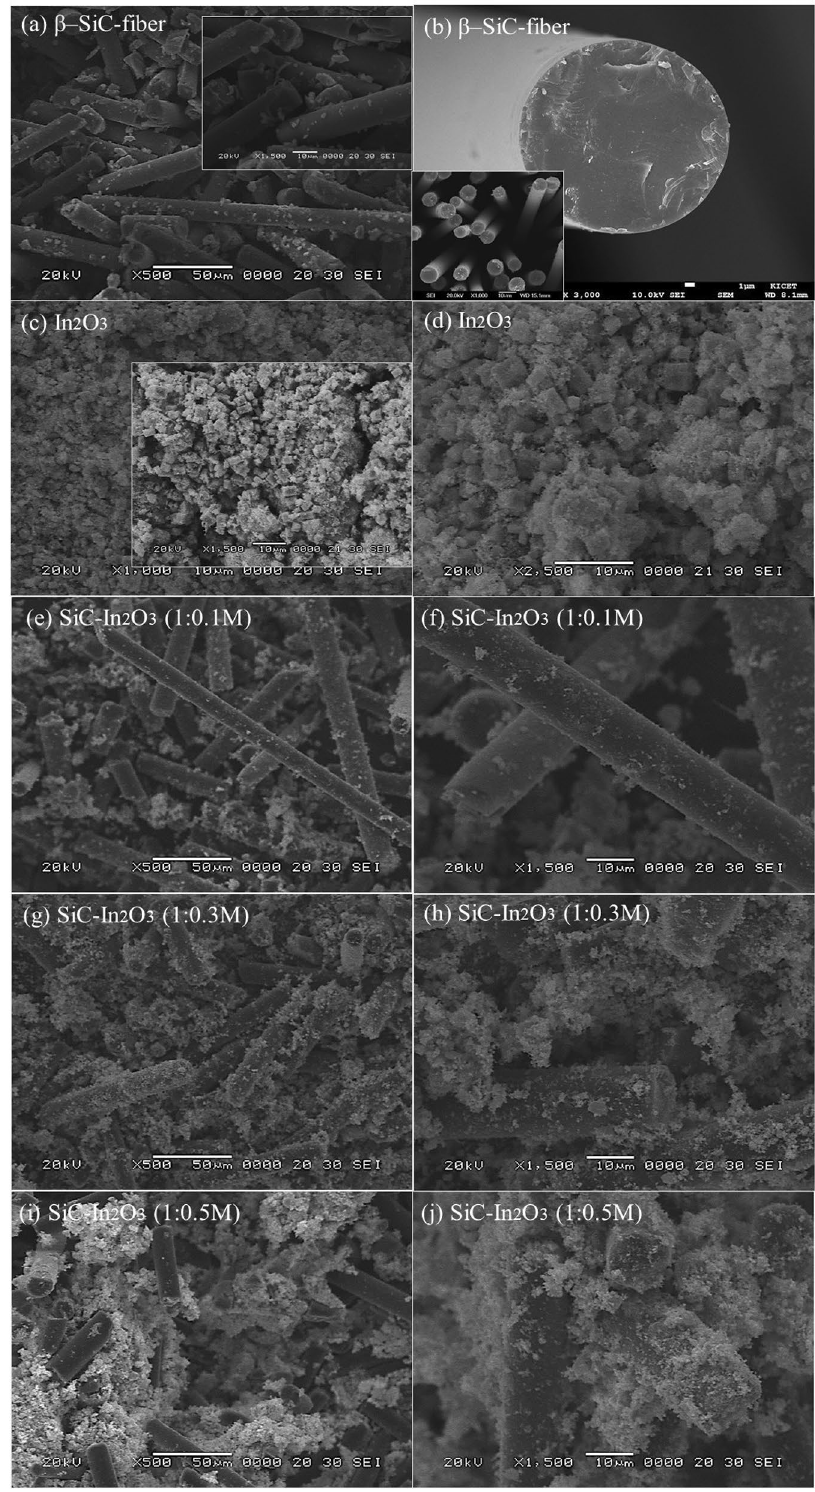
Figure 3. SEM analysis of the ( a , b ) β-SiC fiber, ( c , d ) In 2 O 3 and ( e – j ) SiC-In 2 O 3